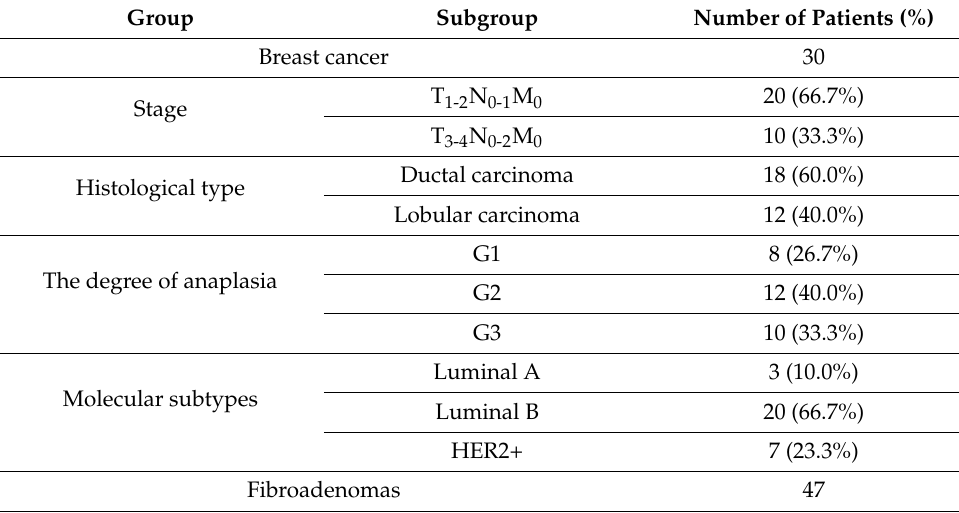
Table 1. Description of the group of patients with breast